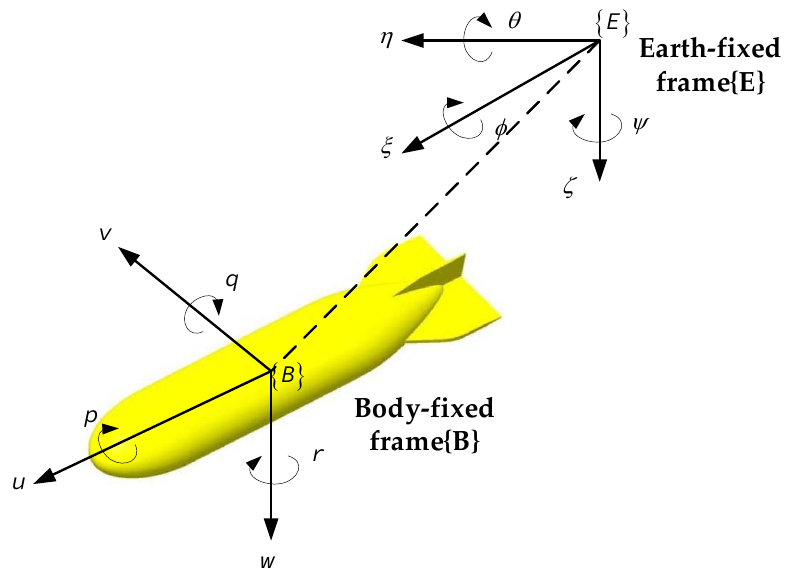
Figure 1. Coordinate system of a UUV.